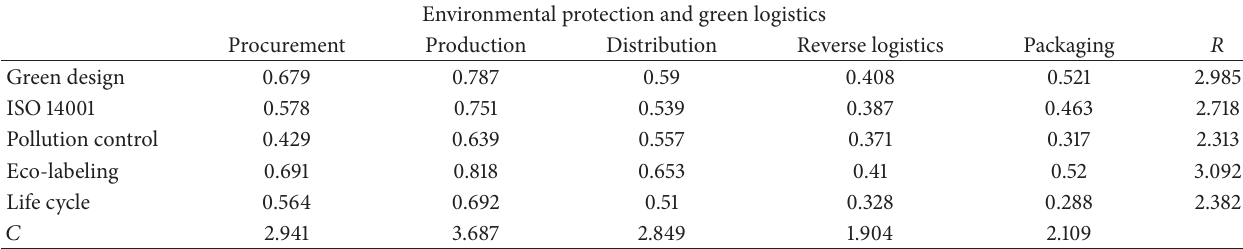
Table 1: Total-relation matrix of environmental protection and green logistics.